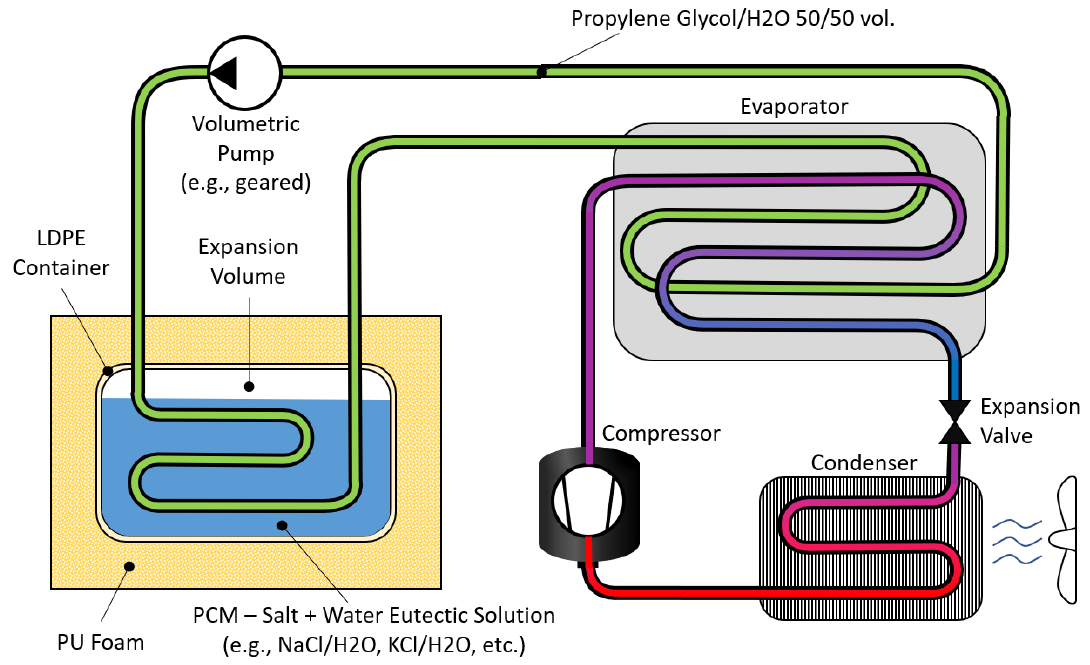
Figure 10. Concept of an active PCM cold storage system for a refrigeration/freezing appliance [57].